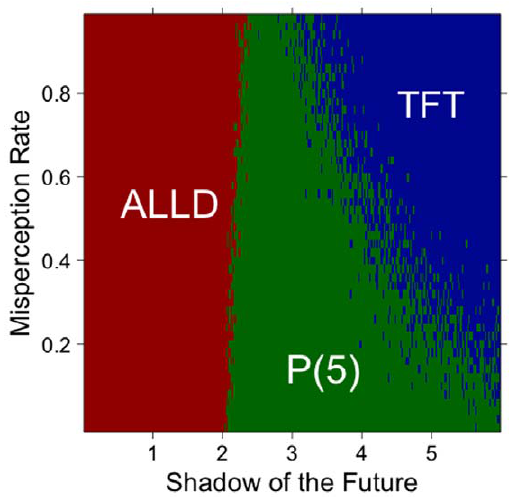
Figure 7. Strategies with the highest average score, as a function of the rate of misperception. The rate of misperception refers to the probability that a prejudiced player will record its opponent’s attributes with some mistake. For example, a true sequence of traits ½ 1,1,1 (cid:2) might be recorded as ½ 1,0,1 (cid:2) . The higher the misperception rate, the more often a prejudiced player will wrongly record one of her opponent’s traits. Here, the rate of misperception affects the range of shadow of the future for which prejudiced players (here P(5)) perform better than any other strategies. The results are based on one hundred simulations with 50% TFT, 50% ALLD and